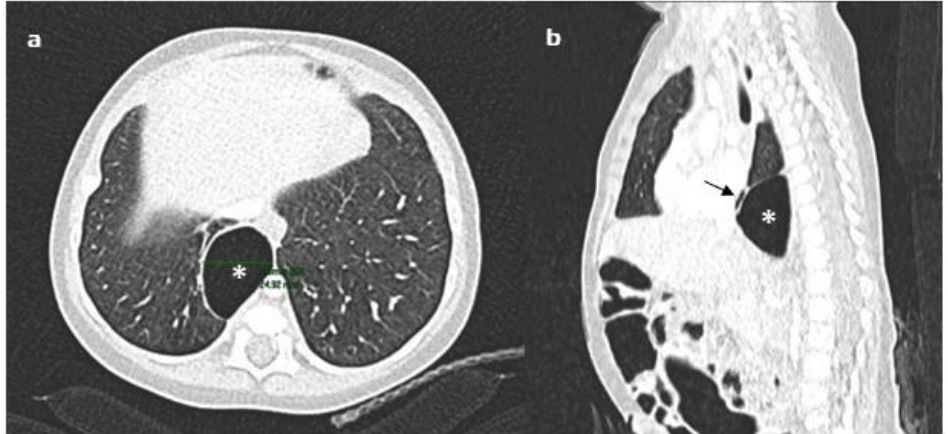
Figure 2. Chest CT scan with contrast enhancement showing the oval-shaped lesion in the posterior mediastinum (indicated by the asterisk): ( a ) the lesion minimally compressed the adjacent lung parenchyma, and ( b ) anteriorly dislocated the oesophagus (black short